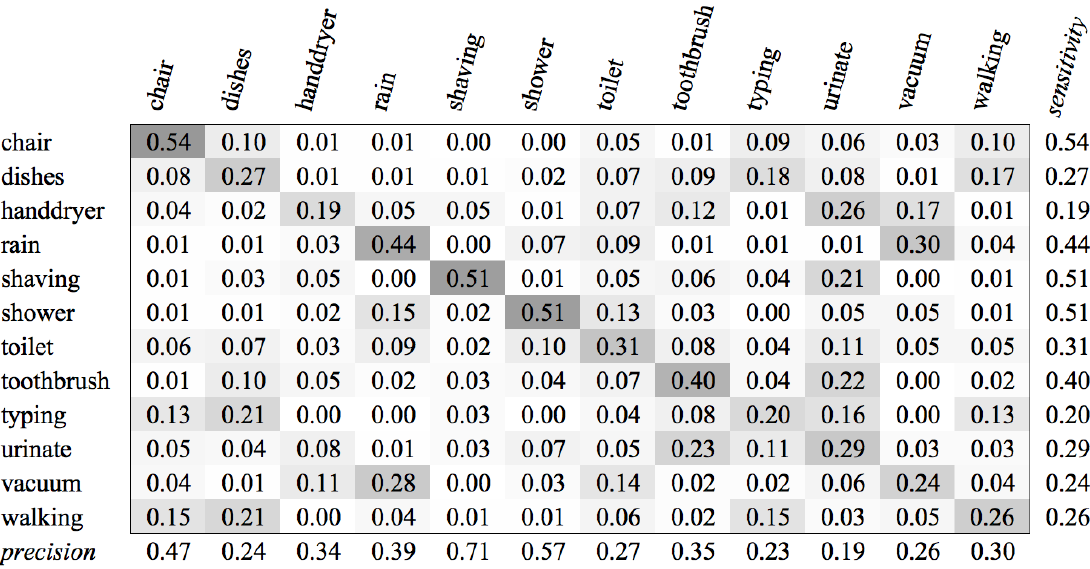
Figure A9. SVM confusion matrix of category Environment for MFCC feature